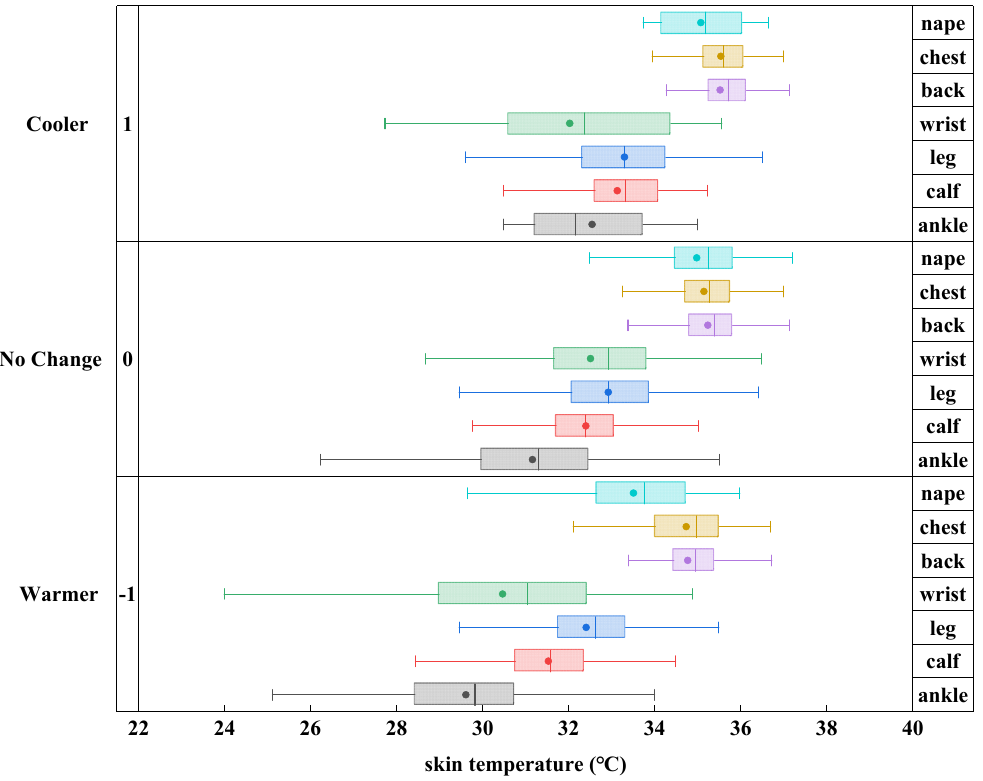
Figure A4. Local skin temperature and thermal preference.